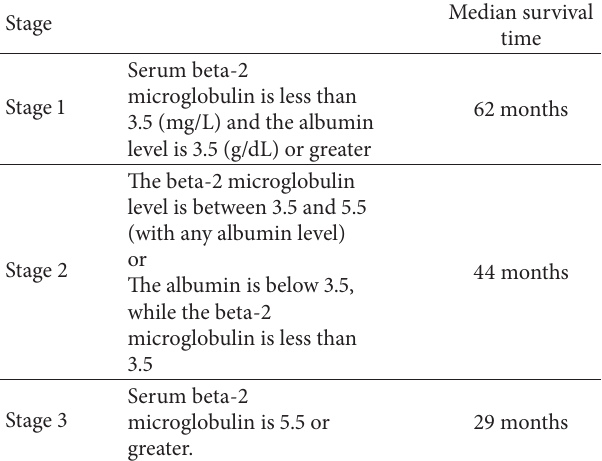
Table 4: ISS staging of multiple